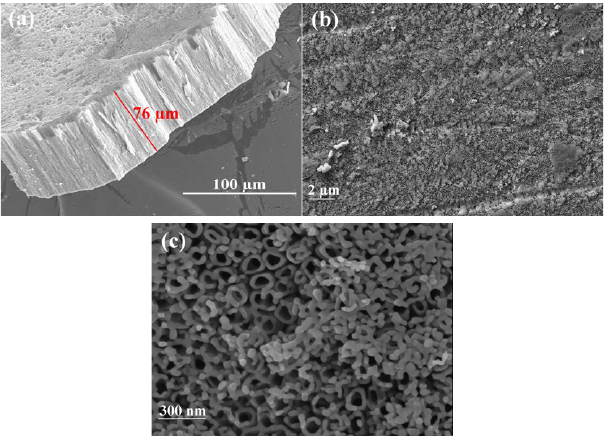
Figure 2. FESEM micrographs for anodized titania nanotube arrays ( a ) after the anodization process (60 V, 25 ◦ C, 20 h), and following SRD experiments and viewed with ( b ) low, and ( c ) high